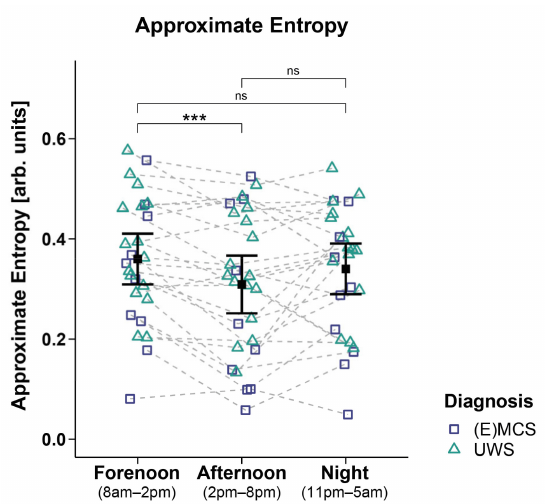
Figure 5. Approximate entropy (ApEn). Patients showed a higher ApEn during forenoon as compared to afternoon. No significant differences were evident between night and day (i.e., night vs. forenoon or afternoon). Error bars represent the mean and 95% confidence interval. *** p < 0.001; ns = not sig- nificant. Abbreviations: (E)MCS = (emergence from) minimally conscious state; UWS = unresponsive wakefulness syndrome; arb. units = arbitrary